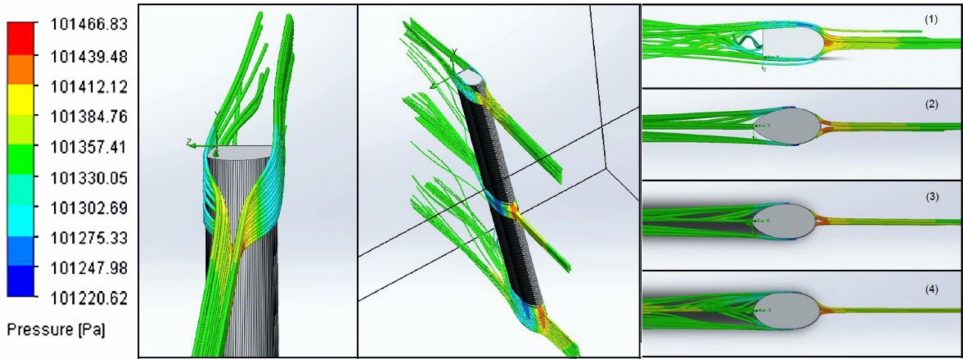
Figure 14. Flow and pressure area lines on seat tube cross-sections in design point 1. From left to right: the two left pictures show the flow lines around the complex 1 cross-section from different views. The next three pictures show the flow lines around the complex 4, complex 3, and complex 1 cross-sections as viewed from above. The different colors represent the variation of pressure caused when the air flows around the models (red indicates high pressure, blue is low, and green is atmospheric pressure).